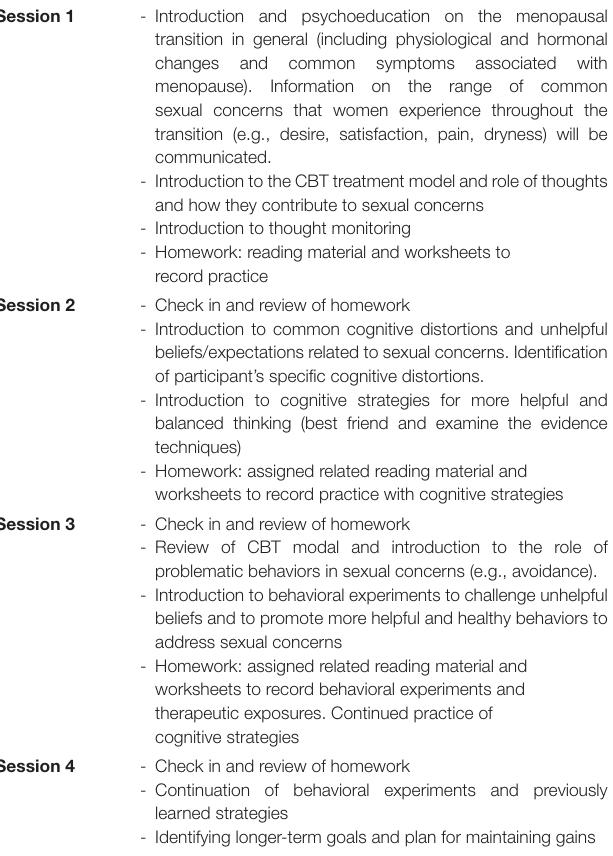
TABLE 2 | CBT-SC-Peri Session-by-Session Content. Session